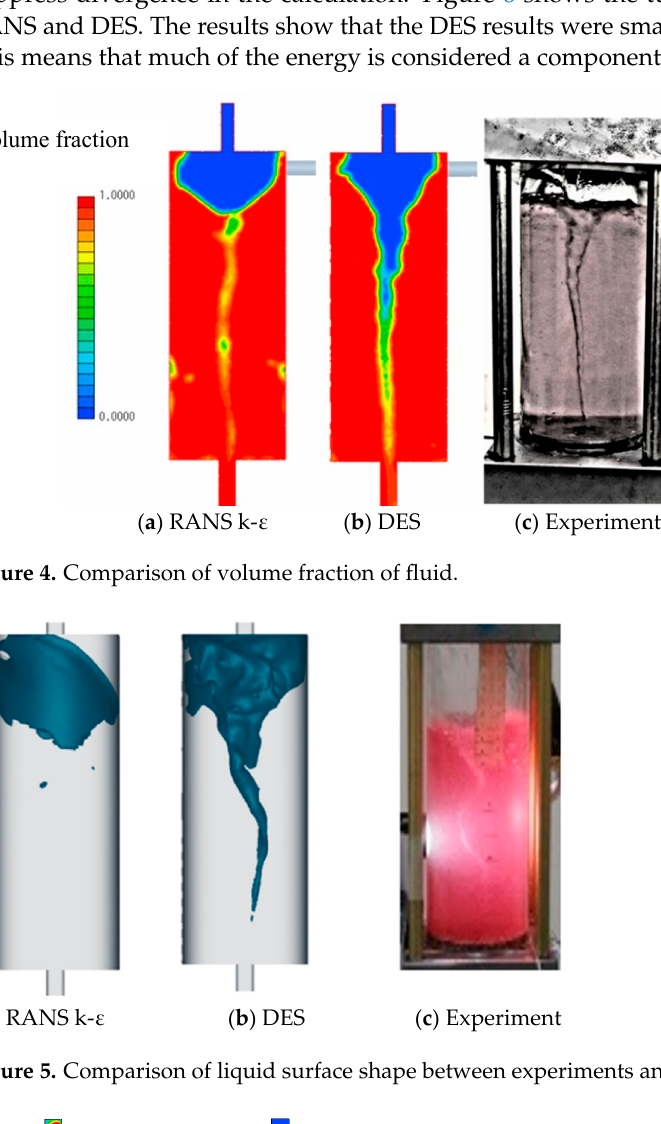
Figure 4. Comparison of volume fraction of fluid.